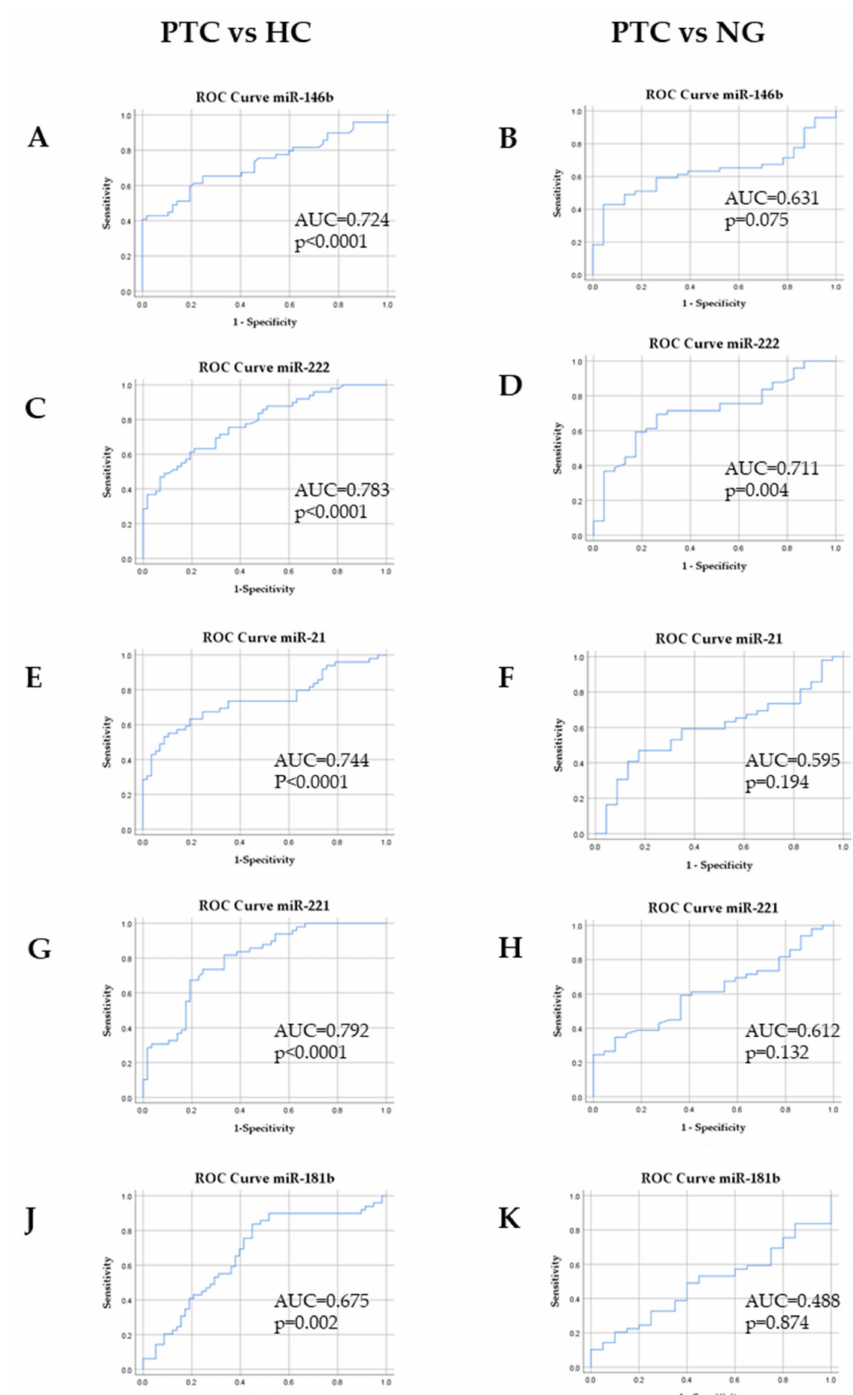
Figure 5. Diagnostic value of miRNAs in discriminating PTC from healthy controls (HC) and nodular goiter (NG). ROC (receiver operating characteristic) curves were used to distinguish the groups. ( A ) Plasma miR-146b in PTC vs. HC and ( B ) NG. ( C ) Plasma miR-222 in PTC vs. HC and ( D ) NG. ( E ) Plasma miR-21 in PTC vs. HC and ( F ) NG. ( G ) Plasma miR-221 in PTC vs. HC and ( H ) NG. ( J ) Plasma miR-181b in PTC vs. HC and ( K ) NG. ROC, receiver operating characteristic; AUC, area under the curve; PTC, papillary thyroid cancer; NG, nodular goiter; HC, healthy